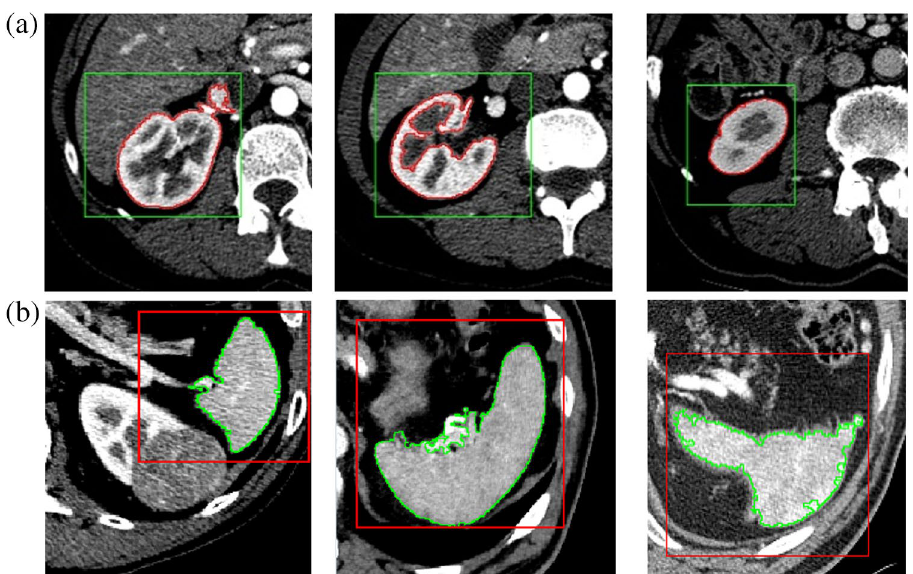
Figure 16. Examples of kidneys recognition. The rectangle indicates the detected ROI. The outline indicates the organ found: kidney ( a ) or spleen ( b